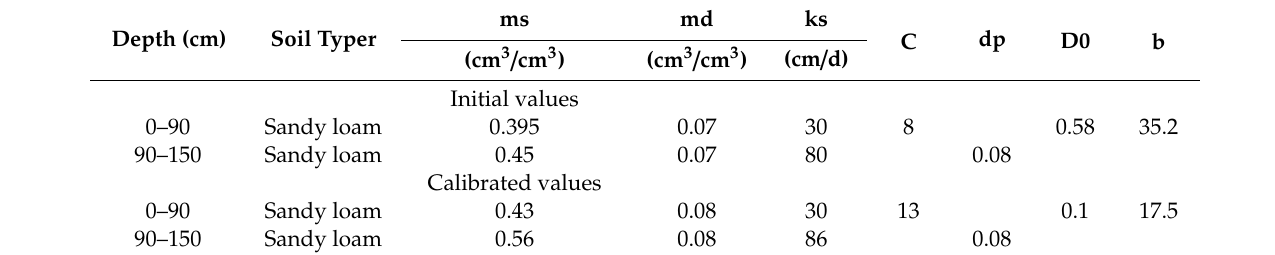
Table 3. Values of hydrological parameters for modified